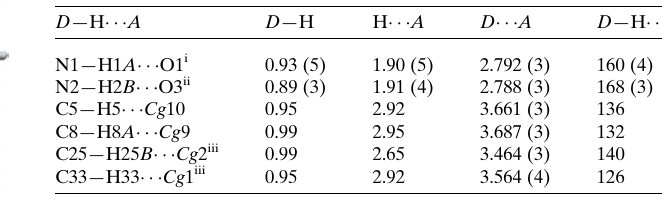
Table 1 Hydrogen-bond geometry (A˚ , (cid:3) ).